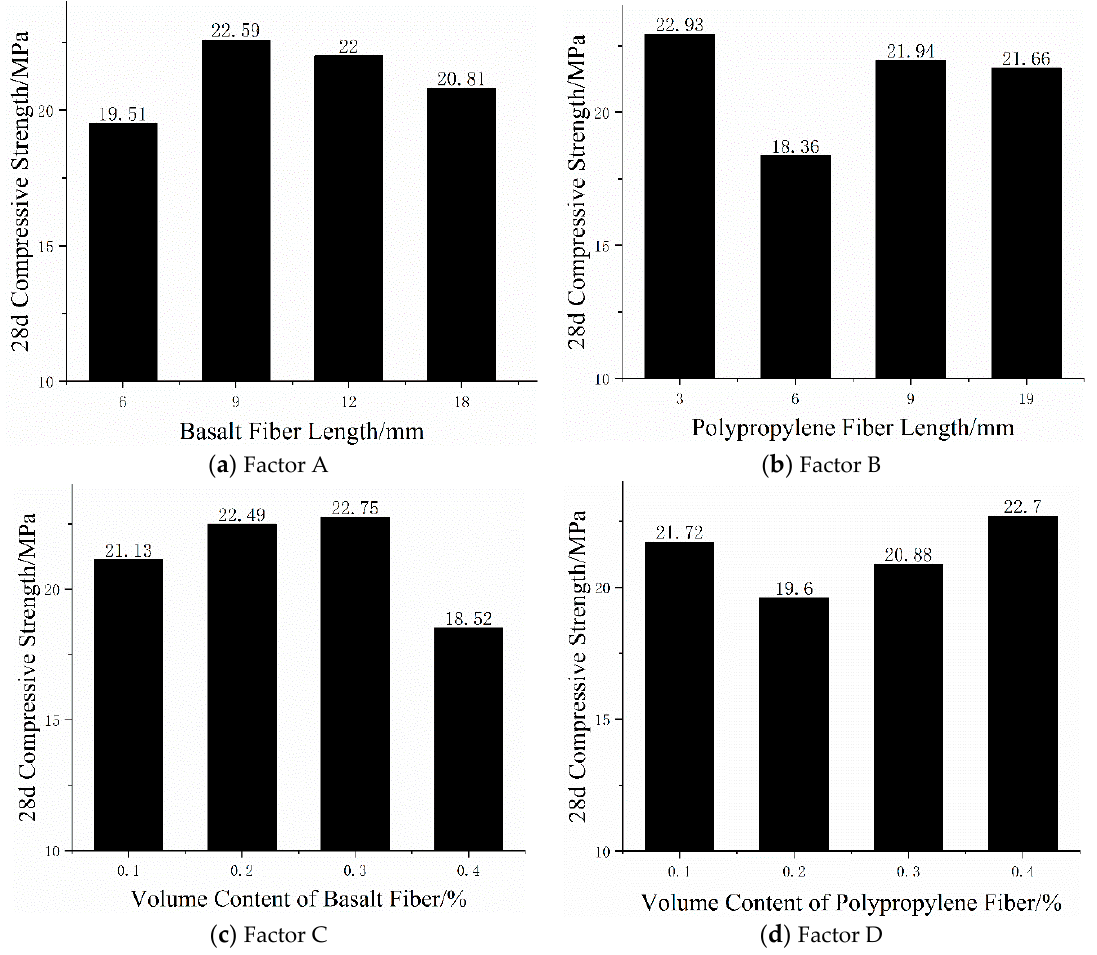
Figure 4. Relationship between four factors and compressive strength.